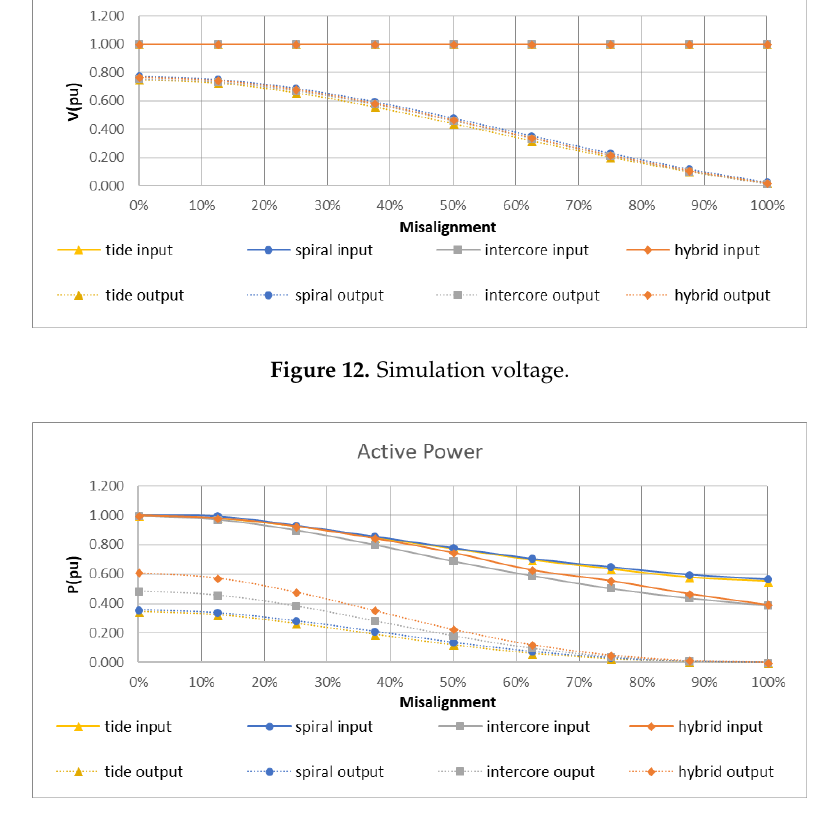
Figure 13. Simulation active power.